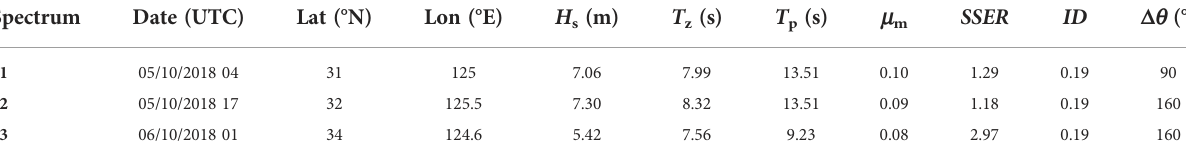
TABLE 1 Main characteristics of the selected bimodal spectra during typhoon Kong-Rey (2018) in terms of their integral and crossing sea parameters.